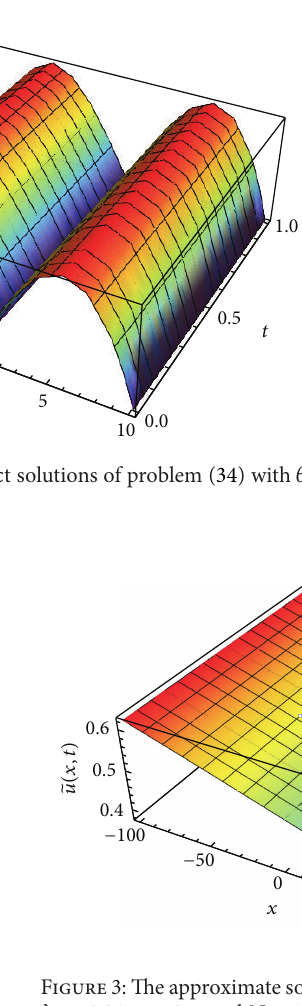
Figure 1: The approximate solution and the exact solution for 𝑡 = 0.5 of problem (34) with 𝜃 = 𝜗 = 1/2 , 𝜆 1 = 0.01 , 𝜏 = 0.5 , and 𝑁 = 12 .